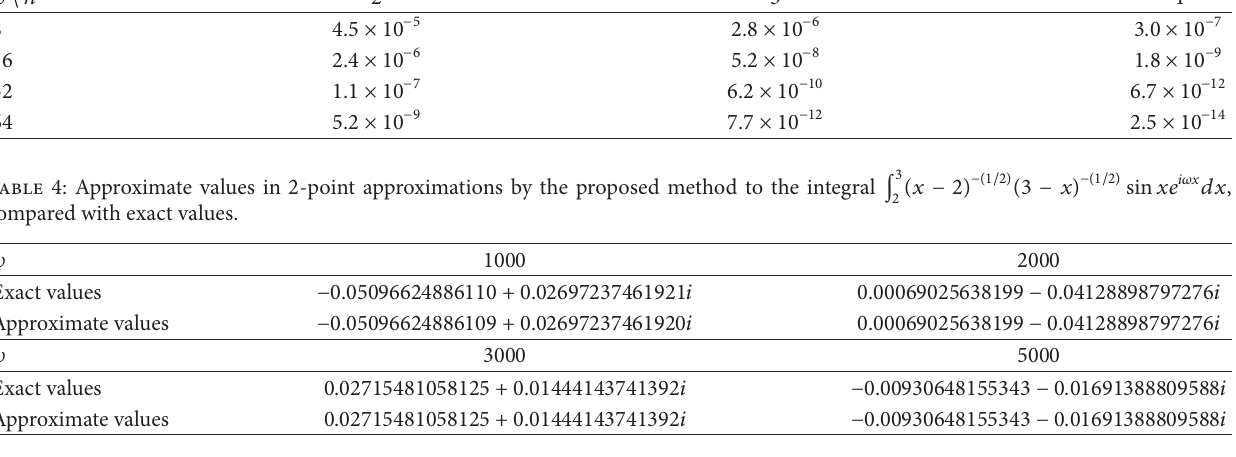
Table 3: Absolute errors in 𝑛 -point approximations by the proposed method to the integral ∫ 𝜔 \ 𝑛